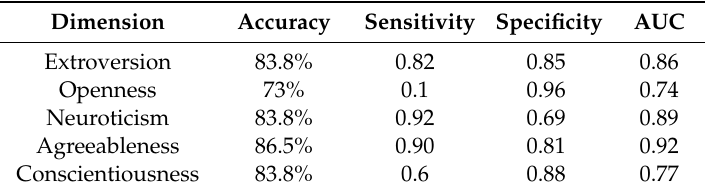
Table 4. Results for fusion